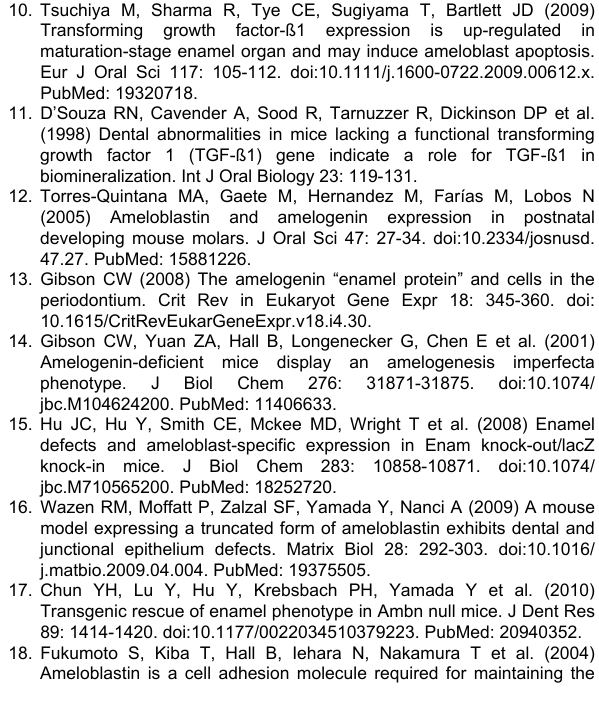
Figure S2. Generation of Tgf-ß R2 cKO mice showing abrogation of TGF-ß signaling in ameloblasts. (A) Schematic diagram showing strategy to detect wild-type, floxed Tgf-ß R2, and cKO alleles using PCR primers P1, P2, P3 and their expectant PCR products; (B) PCR analysis demonstrating generation of Tgf-ß R2 cKO mouse (Lane 6). Lane 1: 100 bp marker, Lanes 2 and 5: tail and tooth DNAs of floxed Tgf-ß R2 control mice, Lanes 3 and 6: tail and tooth DNAs of cKO mice, Lanes 4 and 7: tail and tooth DNAs of WT mice, Lanes 2-4: PCR performed with primers 1, 2, and 3, Lanes 5-7: PCR performed with primers 1 and 3 only. (C) Immunohistochemistry of TGF-ß receptor II demonstrating knocked down expression of TGF-ß signaling in ameloblasts.